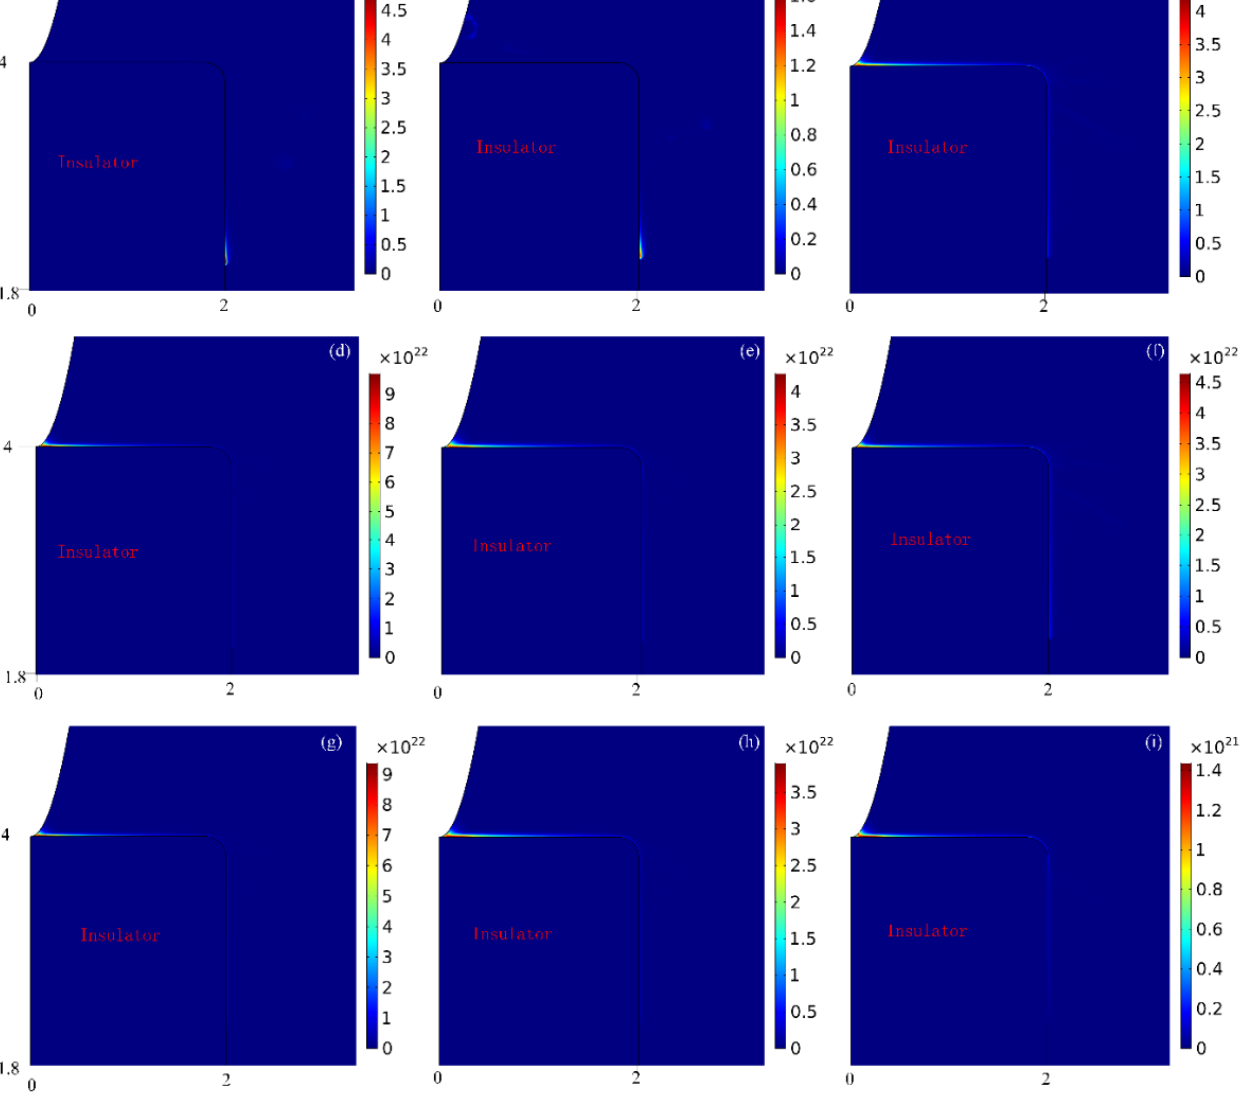
Figure 8. Particle distribution: ( a – c ) electron distribution (m − 3 ) of 10%c-C 4 F 8 /20%CF 3 I/70%N 2 , 30%SF 6 /70%N 2 and artificial air; ( d – f ) positive ions (m − 3 ) distribution of 10%c-C 4 F 8 /20%CF 3 I/70%N 2 , 30%SF 6 /70%N 2 and artificial air; ( g – i ) negative ions (m − 3 ) distribution of 10%c-C 4 F 8 /20%CF 3 I/70%N 2 , 30%SF 6 /70%N 2 and artificial air; the scale unit is millimeters (mm).